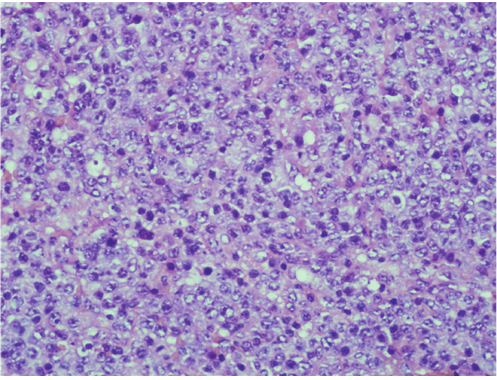
Figure 1: Right axillary node biopsy demonstrating di ff use large B- cell lymphoma.